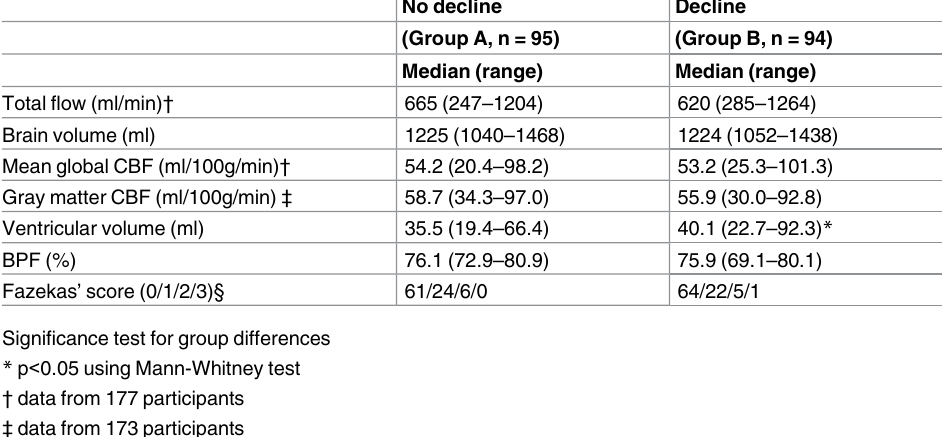
Table 2. Whole brain magnetic resonance imaging